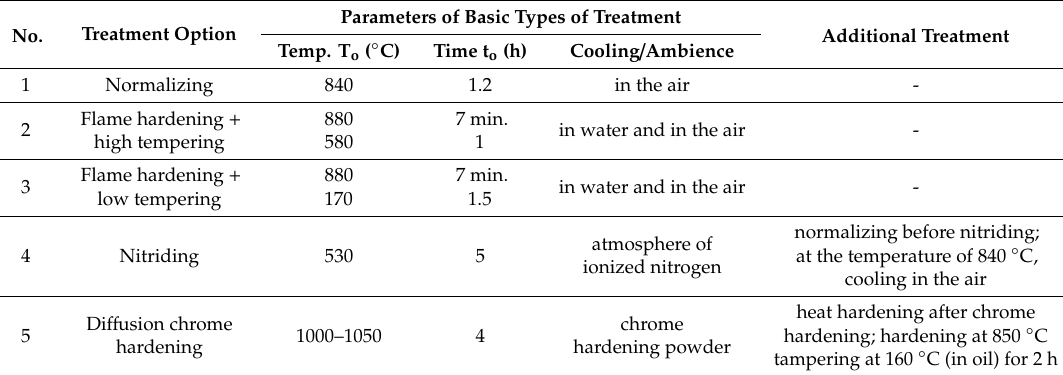
Table 4. The used options of heat and thermochemical treatment [40].